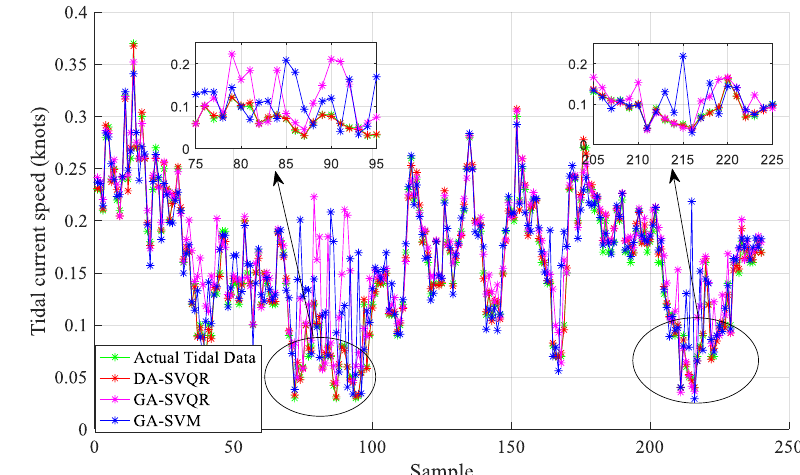
Figure 8. Method comparison diagram.